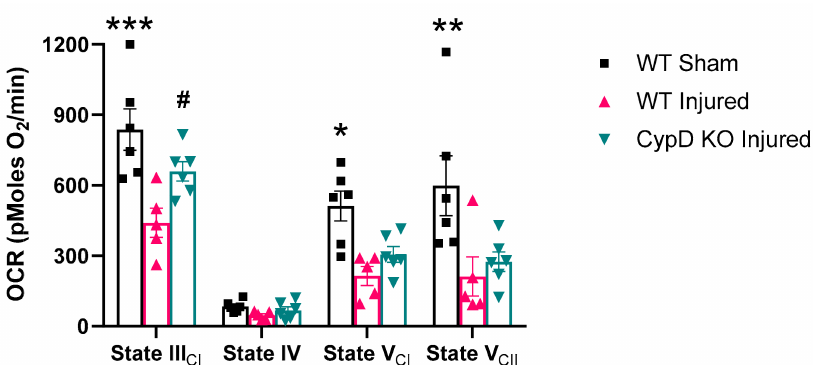
Figure 1. Cyclophilin D (CypD) knockout attenuates mitochondrial dysfunction following traumatic brain injury (TBI). At 6 h post-injury, complex I driven State III respiration was significantly reduced compared to sham in wild-type (WT) animals. However, CypD knockout attenuated State III mitochon- drial dysfunction after TBI. For State V respiration, there was no significant difference between WT Injured and CypD KO Injured. * p = 0.0046 vs. WT Injured, ** p < 0.002 vs. WT Injured and knockout (KO) Injured, *** p = 0.0001 vs. WT Injured, # p = 0.047 vs. WT Injured. Five µ g mitochondrial protein were added to each well. Data points represent group mean ± SEM. N =